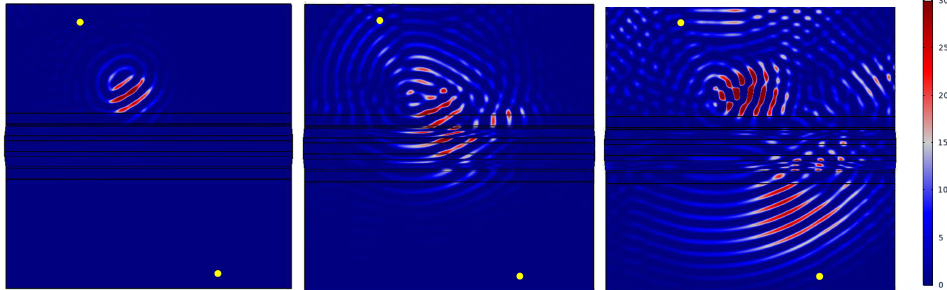
Figure 20. Exemplary representation of the wave propagation in the test specimen. The wave field of the differential signal (undamaged–damaged) is shown for a damage of size 671 mm 2 at position D1 and the actuator-sensor path T2–T11. The time steps 150 µ s, 250 µ s and 350 µ s were